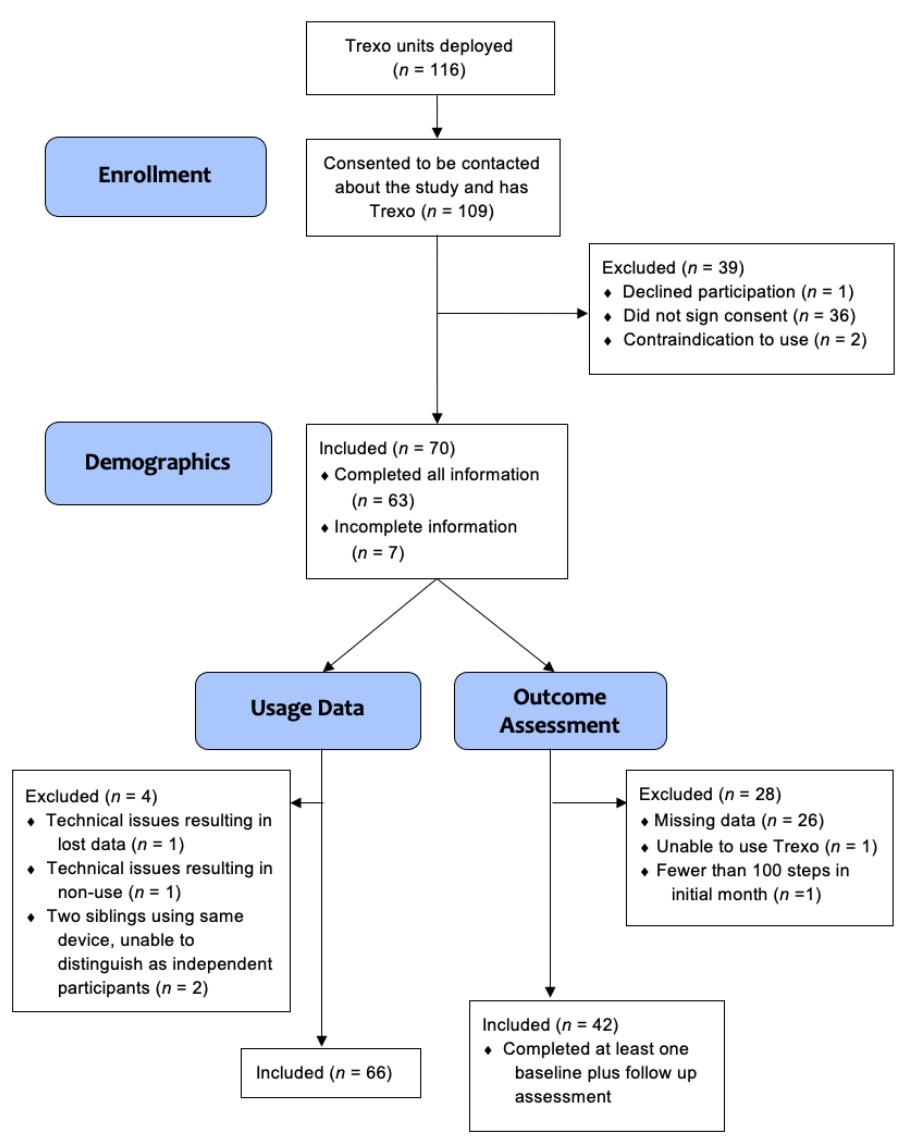
Figure 2. Participant flow diagram.